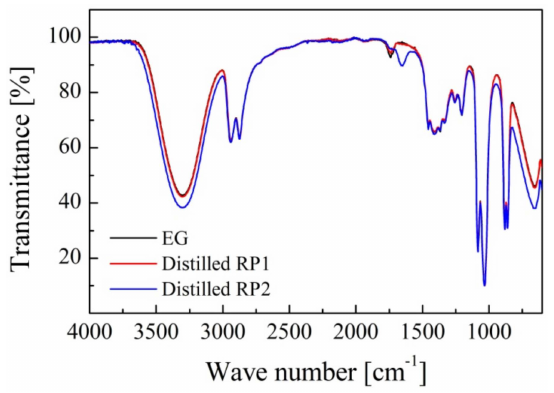
Figure 3. FTIR spectra of EG and distilled